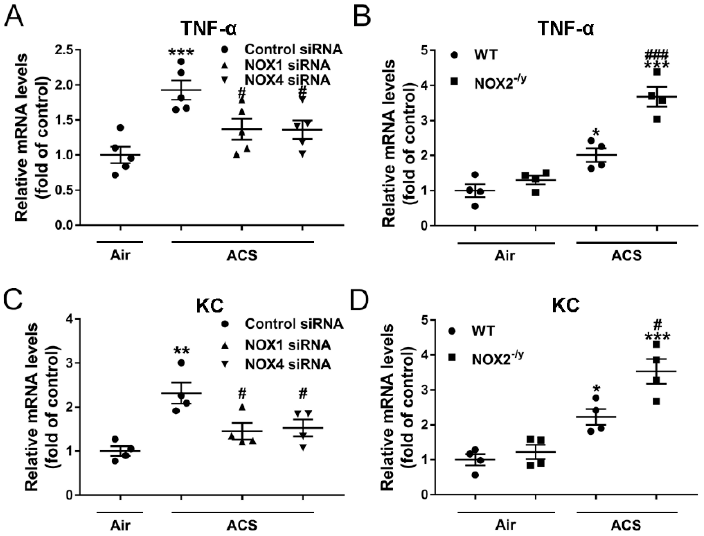
Figure 6. Knockdown of NOX1 or NOX4 in mice attenuated ACS induced upregulation of pro- inflammatory mediators in the mouse lung . Mice were exposed to CS or filtered air for 1 h and harvested at 6 h. The mRNA expression levels of ( A , B ) TNF- α and ( C , D ) KC in the lungs of ACS exposed mice silenced or knocked down of NOX1, NOX2, or NOX4 were determined by RT-qPCR. The data indicate that ACS induced upregulation of TNF- α /KC in mouse lungs was significantly attenuated in NOX1- or NOX4-silenced mice, while it was increased in NOX2 − /y mice. All data are presented as Mean ± SEM, n = 4–5. * p < 0.05, ** p < 0.01, *** p < 0.001 vs. air exposed control group. # p < 0.05, ### p < 0.001 vs. ACS exposed